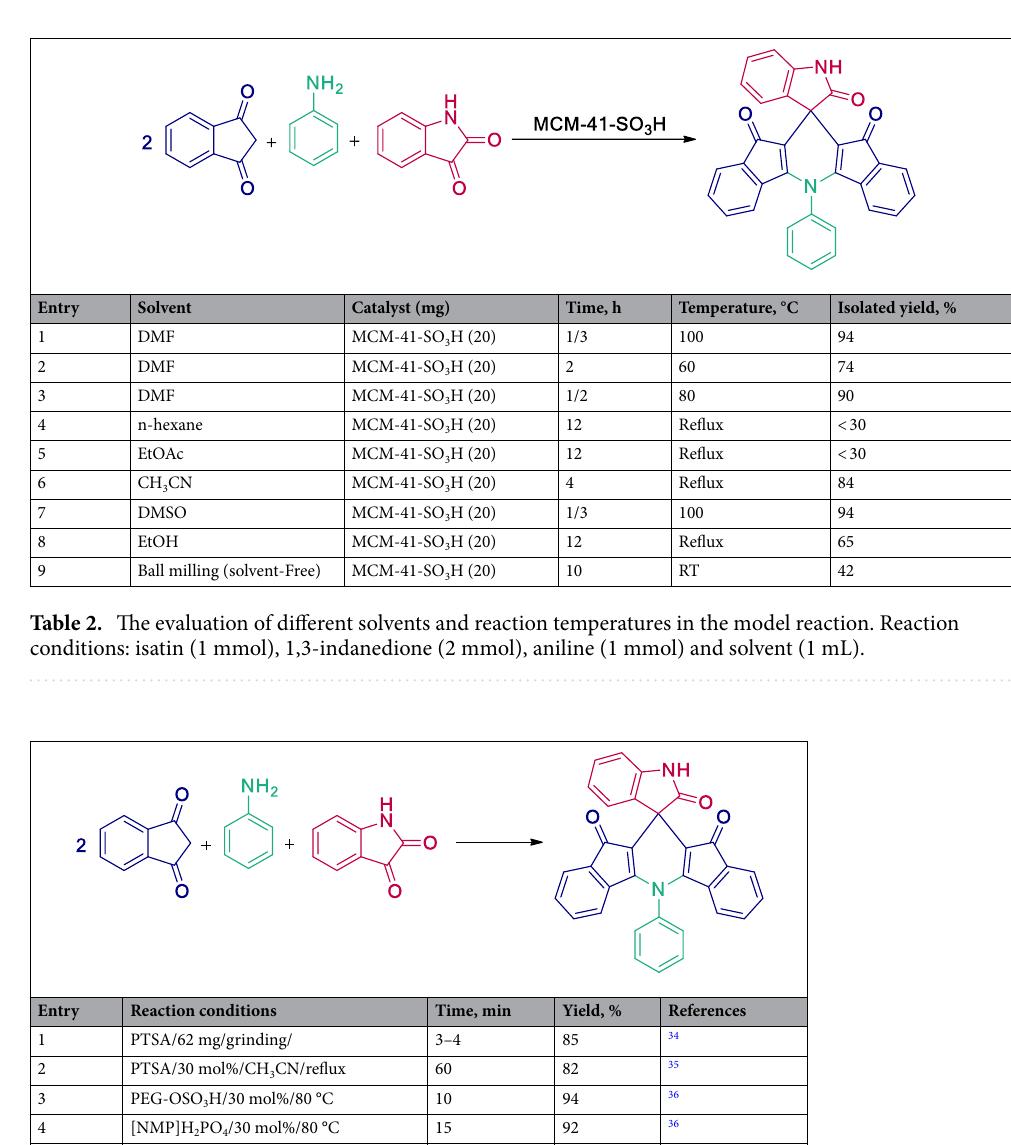
Entry Reaction conditions Time, min Yield,